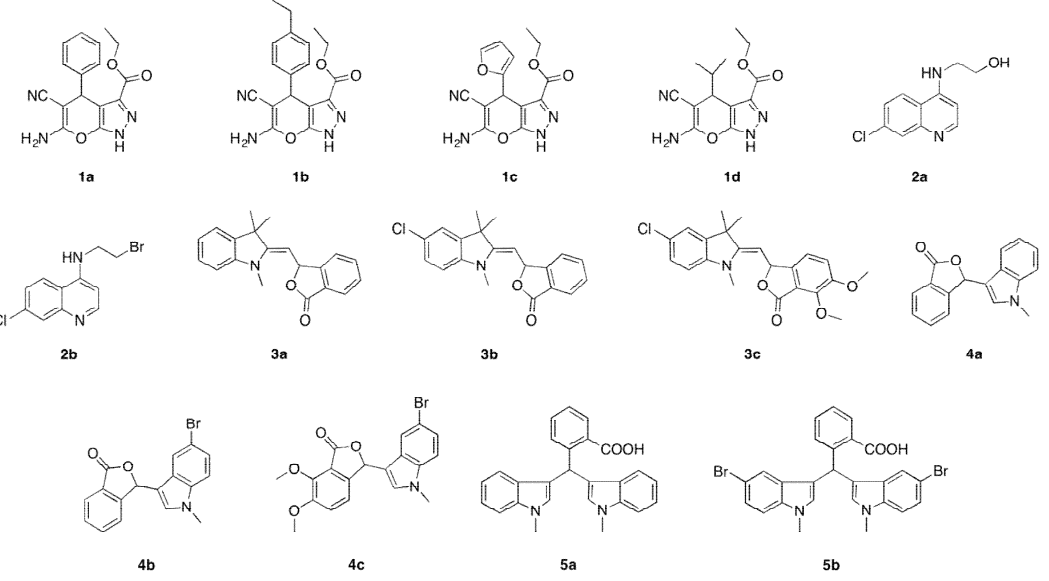
Figure 2. Structure of N -heterocyclic compounds comprising pyranopyrazole ( 1a–d ), quinoline ( 2a–b ), phthalide and bisindole ( 3a–5b ) moieties used for carcinogenic detection.